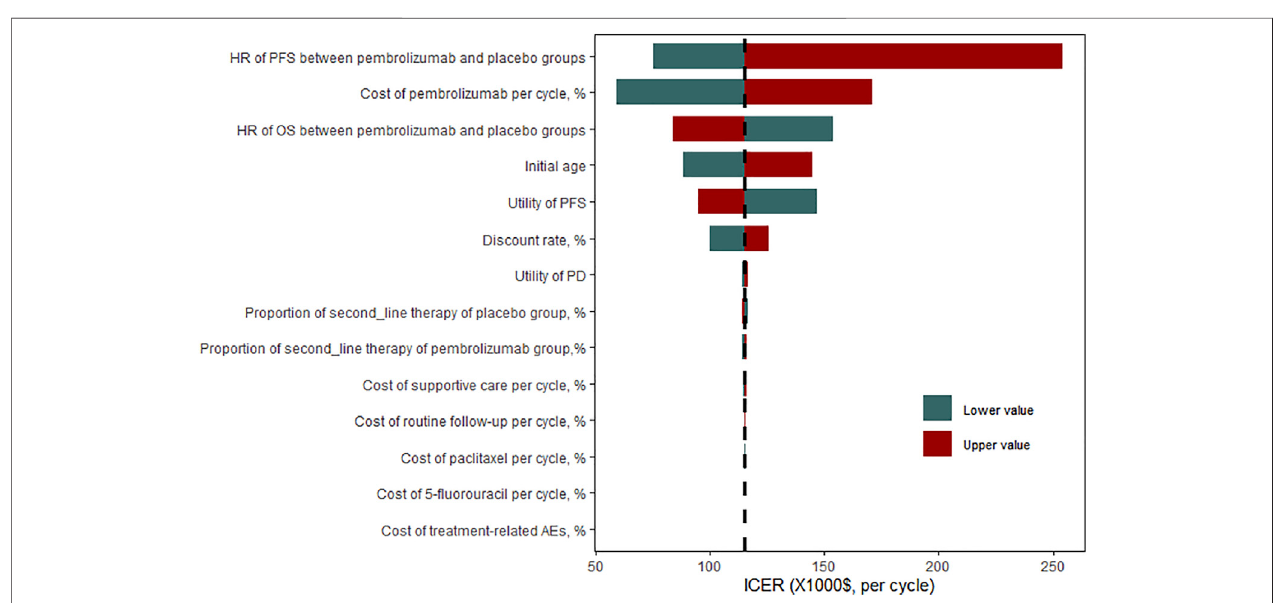
FIGURE 2 | One-way sensitivity analysis for pembrolizumab versus placebo group. HR, hazard ratio; OS overall survival; PFS, progression-free survival; ICER, incremental cost-effectiveness ratio.